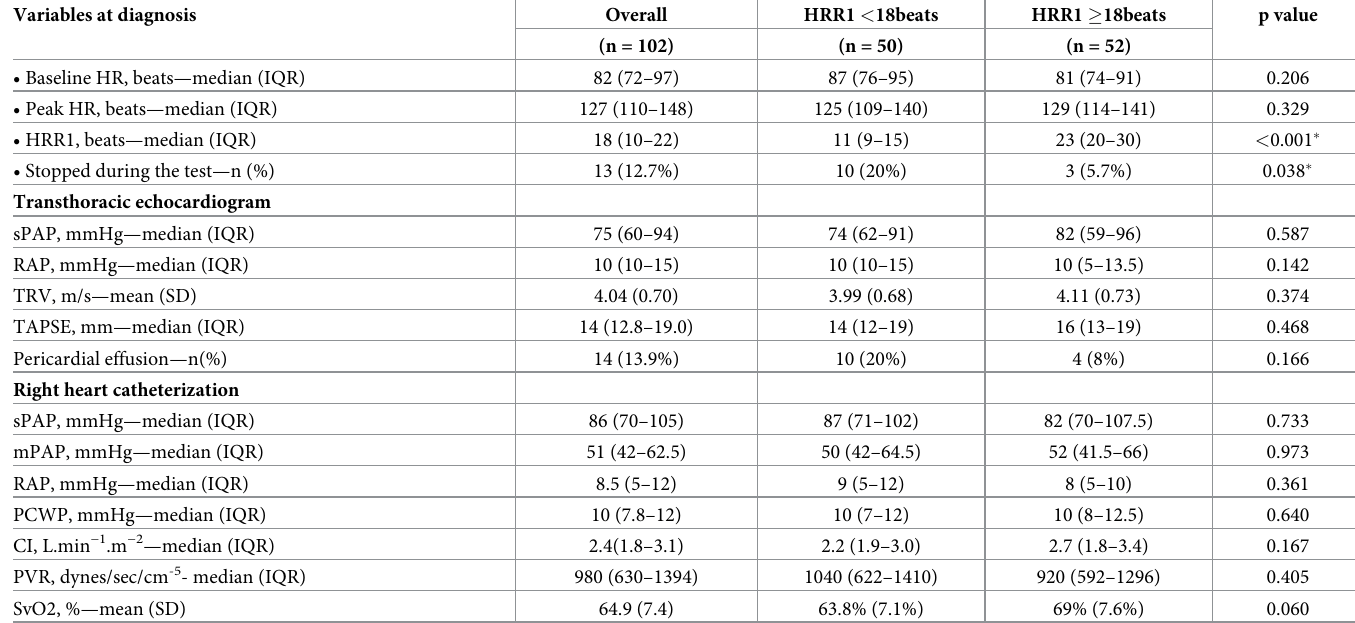
(Fig 2). The distribution of outcomes was disease progression (55%), hospitalization (20%), death (1%) and 24% had no event during the follow-up time. The main causes of death were right ventricular failure (n = 25) followed by sepsis (n = 7), liver failure (n = 4), pulmonary embolism (n = 1) and pulmonary artery dissection (n =